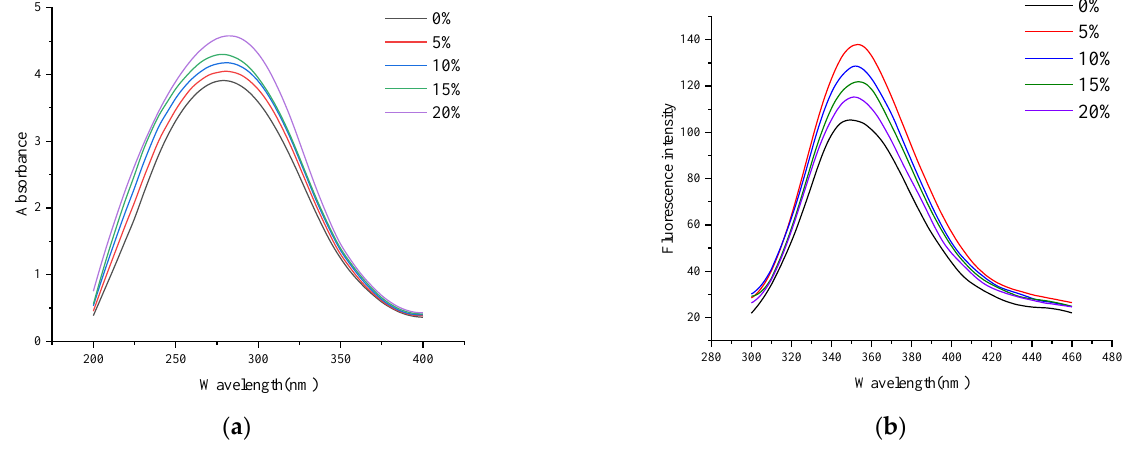
Figure 1. UV-vis spectra ( a ) and fluorescence spectra ( b ) of RB-SPI plant-based simulated meat with different RB contents.